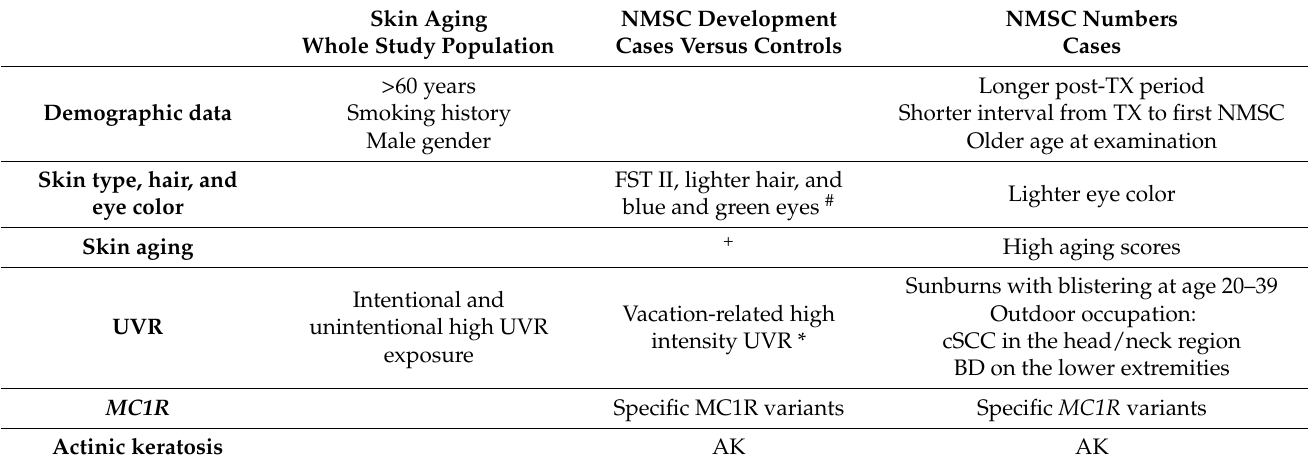
Table 4. Factors associated with skin aging, NMSC development, and NMSC